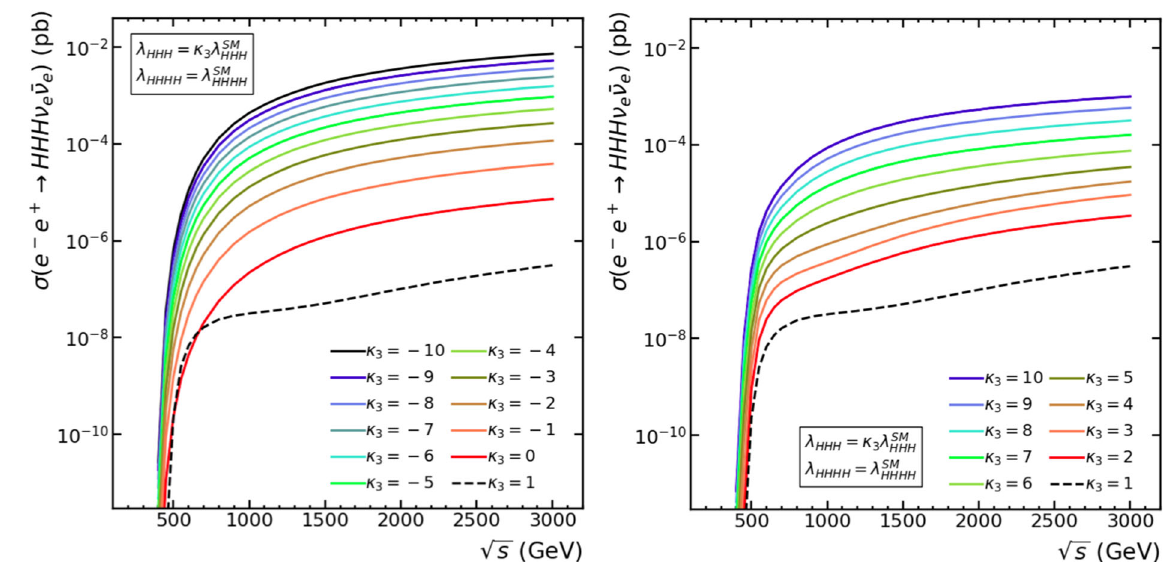
√ s for different values of the parameter κ 3 , with κ 4 fixed to 1,